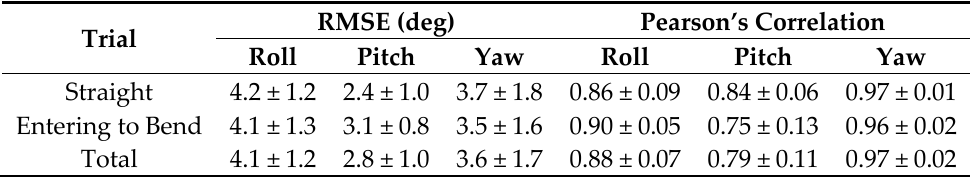
Table 1. Root mean square error (RMSE) of differences and Pearson’s correlation coefficients for pelvic angles between the two systems (mean ± SD).